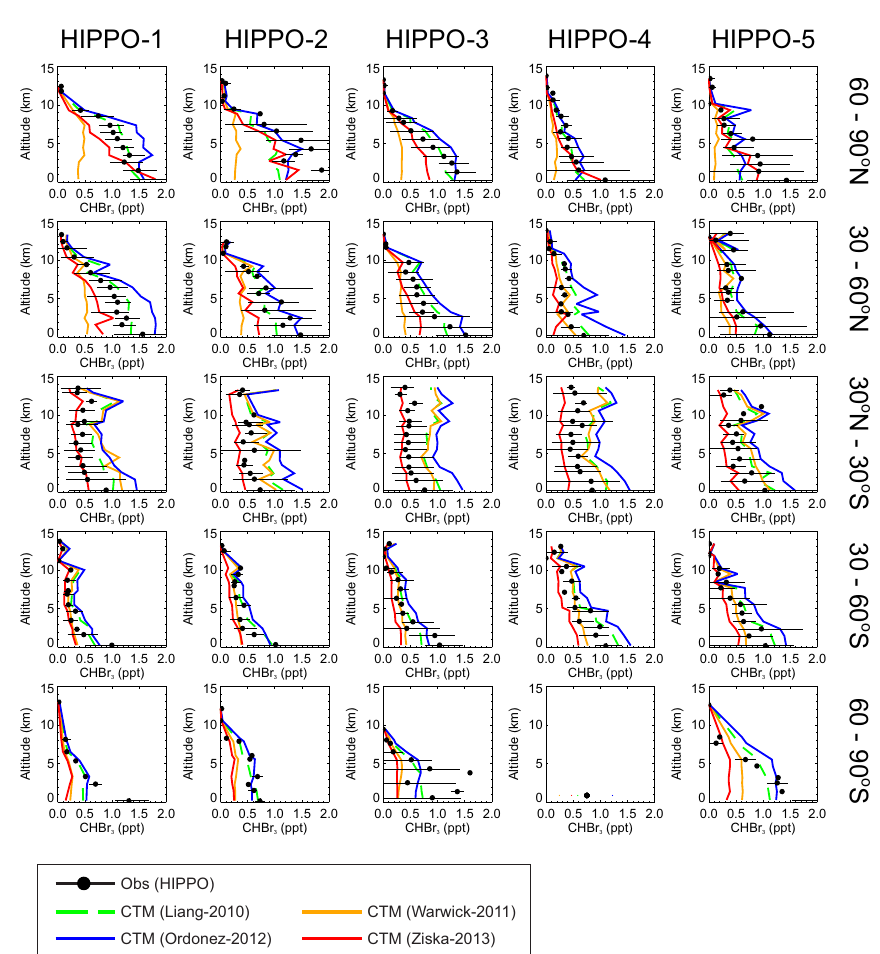
Fig. 7. Comparison of observed CHBr 3 profiles (ppt) made during the NSF HIPPO project (campaigns 1–5, 2009–2011) with analogous modelled profiles from TOMCAT runs S Liang , S Warwick , S Ordonez and S Ziska . All profiles shown are the average for the 5 latitudinal bands considered in this work and are also averaged vertically in ∼ 1km bins. The horizontal lines on the observed data denote the